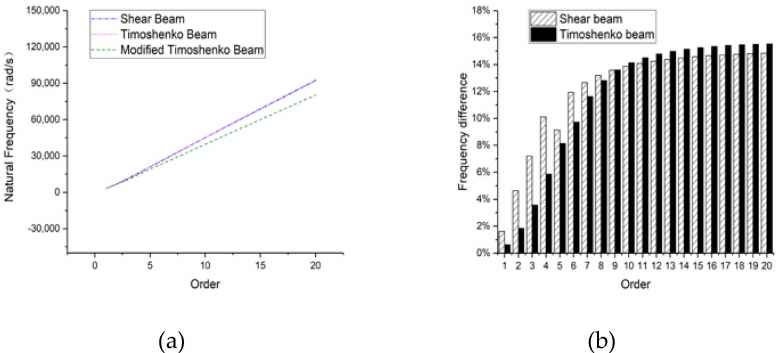
Figure 9. Natural frequencies of the 2-m-long beam: ( a ) overall frequency curve and ( b ) frequency di ff erence compared with a modified Timoshenko